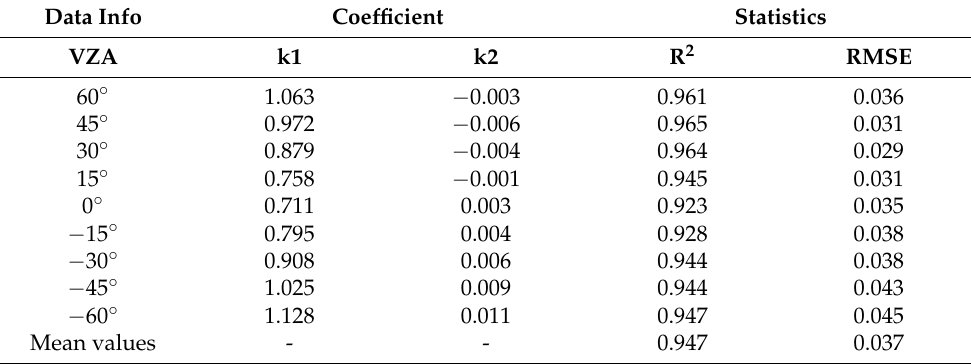
Table 1. Statistics of the relationships between reflectance and spectral albedo.